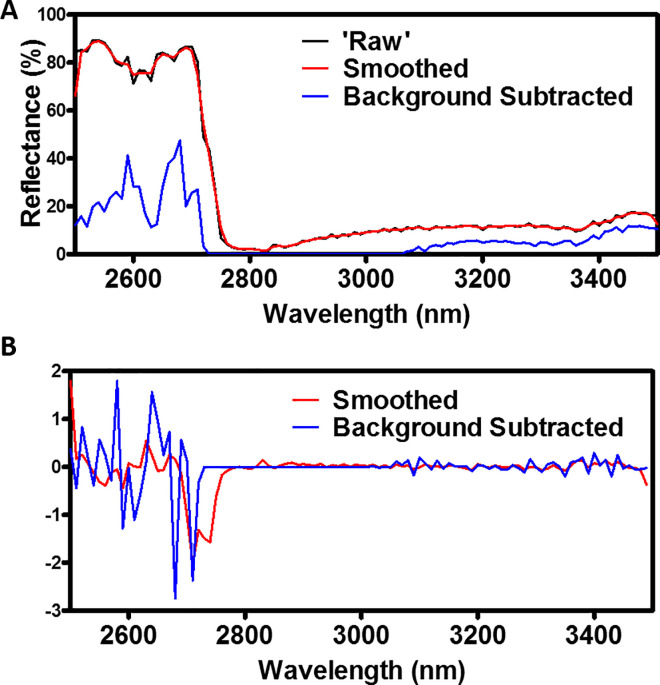
Pre-Processing Data-type visualisations.A: Spectral comparison between the ‘Raw’, smoothed and background subtracted data-types for a single traumatised spectrum. B: Spectral derivative comparison for both the smooth and background subtracted data sets shown in A.